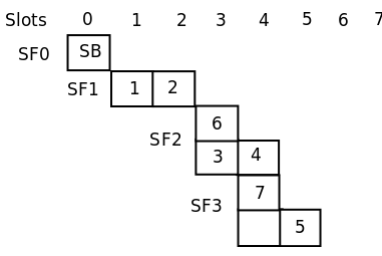
Figure 13. Slot allocation in the example